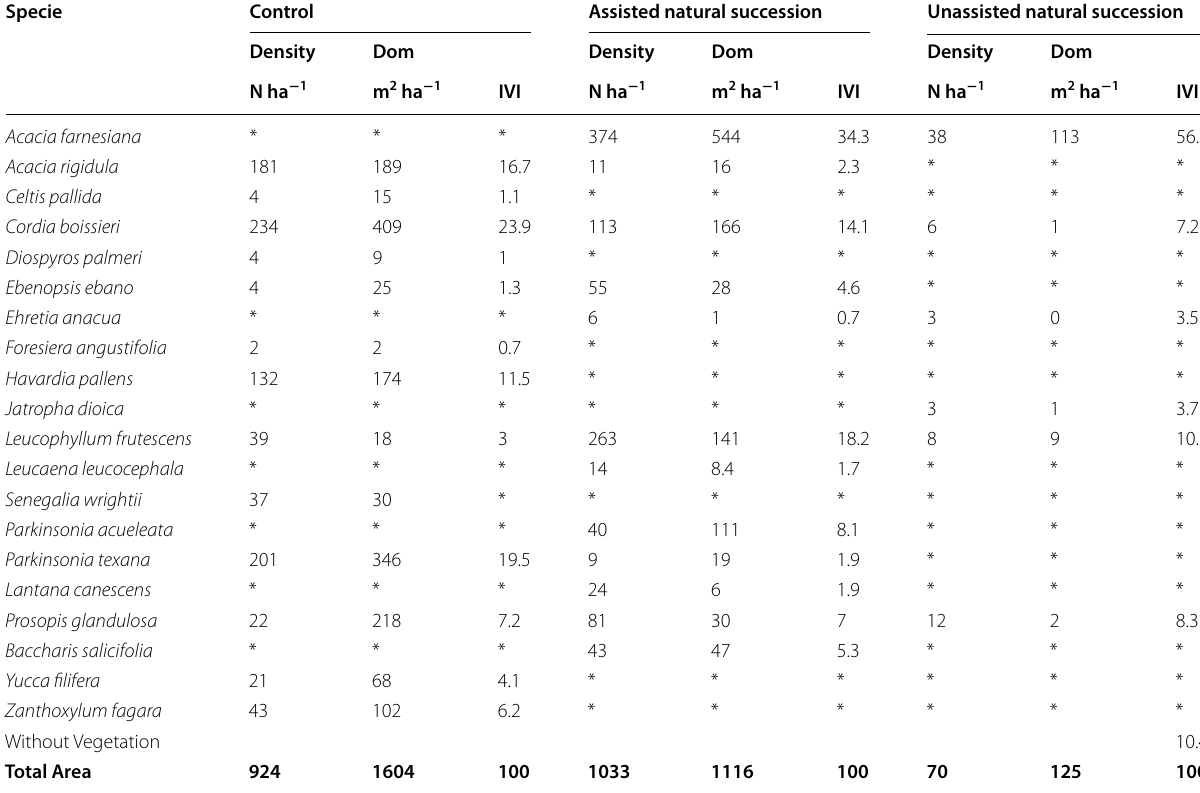
Table 3 Absolute density (number per hectare), absolute dominance (square meters per hectare), and importance value index (IVI, percent) of the three areas